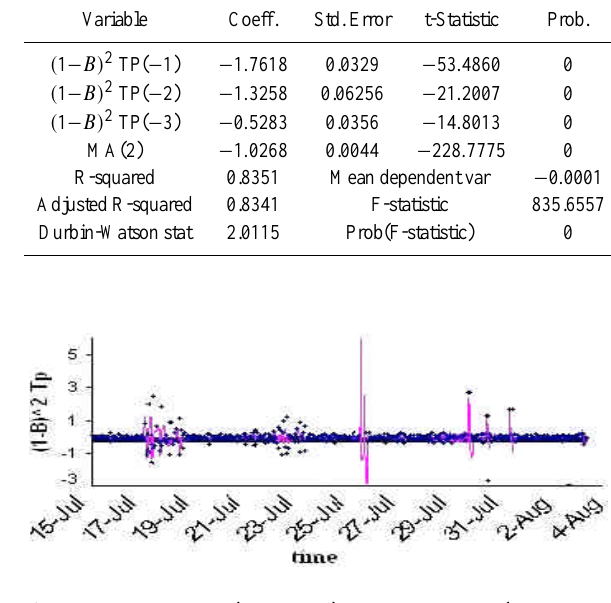
Table 4. Statistical coefficient of dominant period Tp time series model.